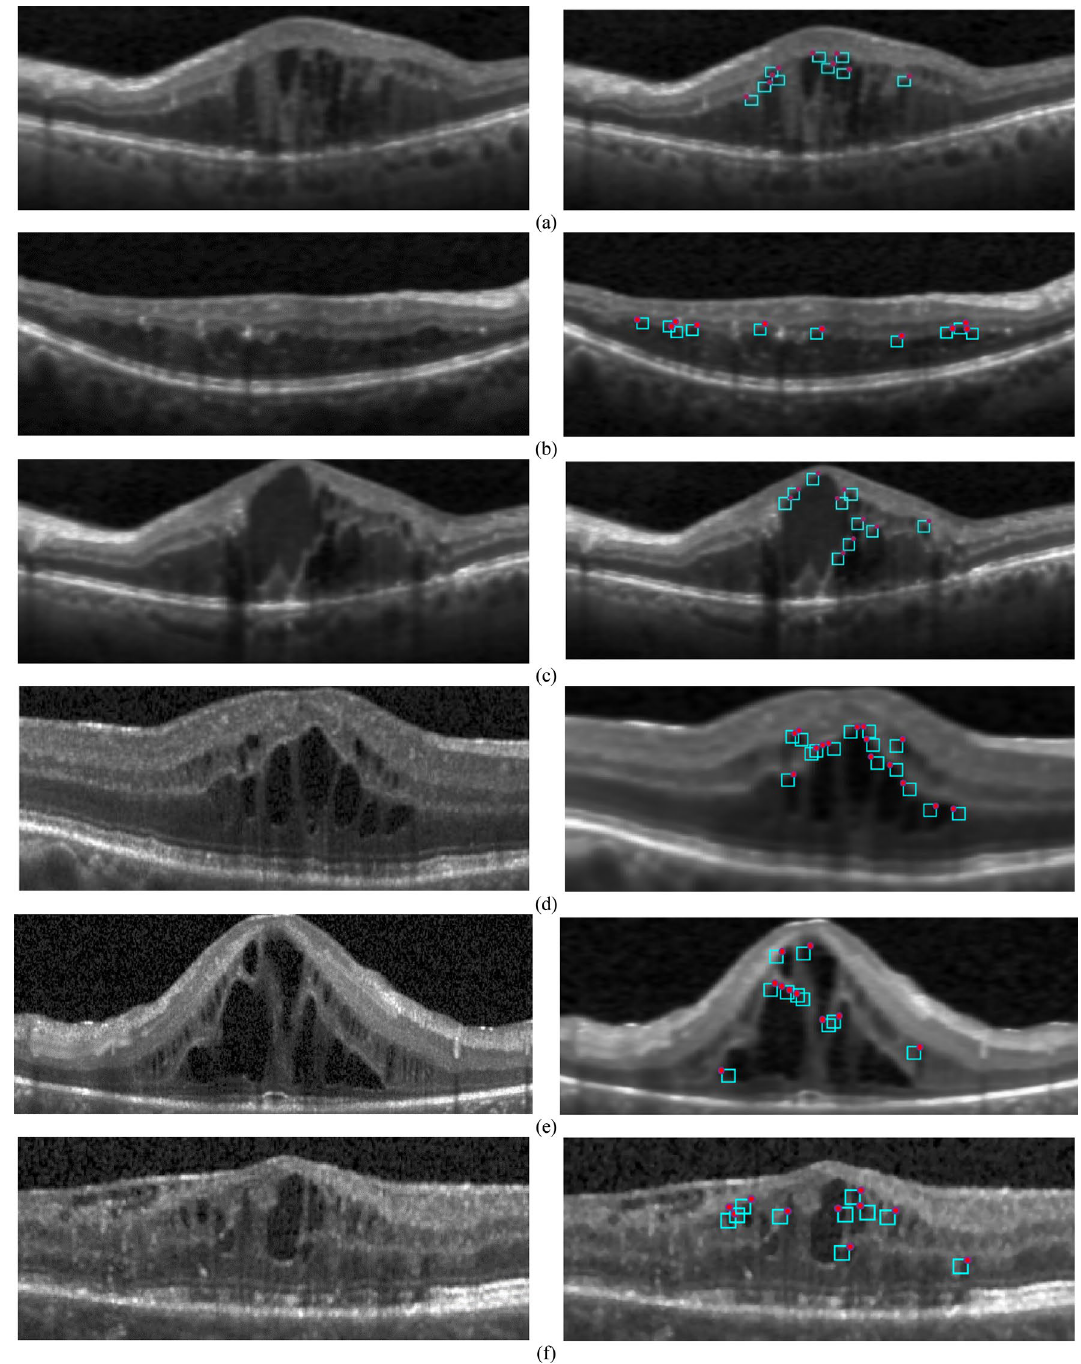
Figure 5. ( a – c ) left parts: Sample OCT B-scans from KR-based dataset, right parts: extracted cystic regions, ( d – f ) left parts: Sample OCT B-scans from Kaggle dataset, right parts: extracted cystic regions.